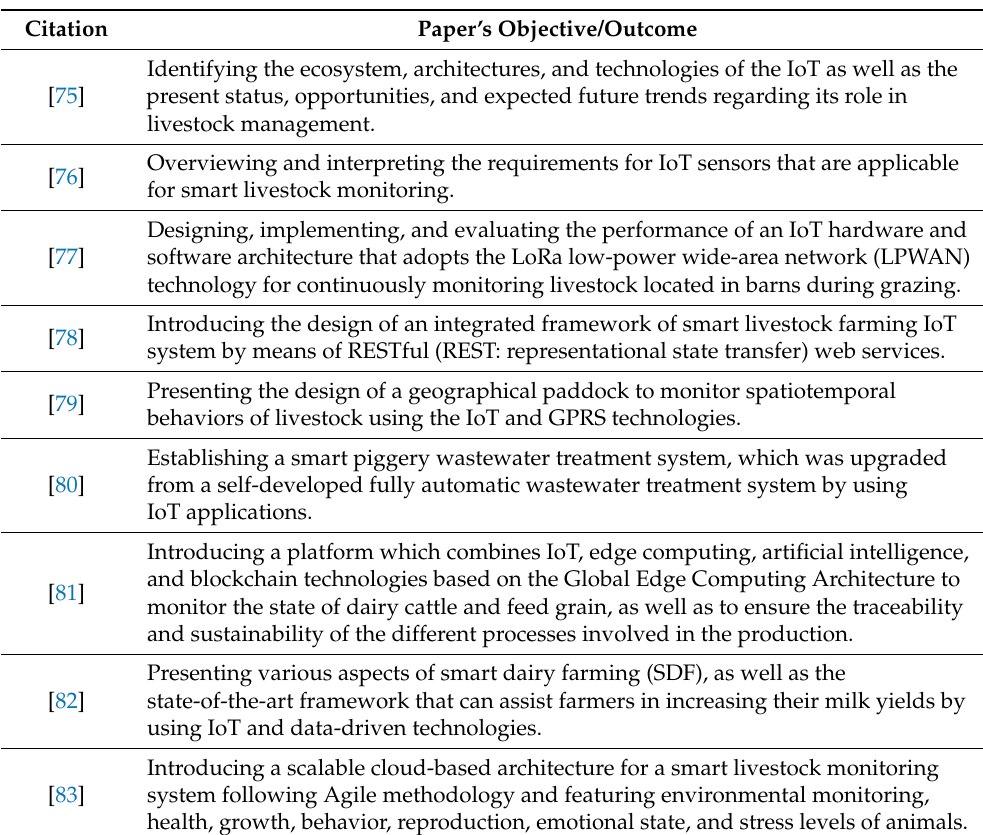
Table 1. Indicative literature results about the utilization of the IoT technologies into livestock farming. Citation Paper’s